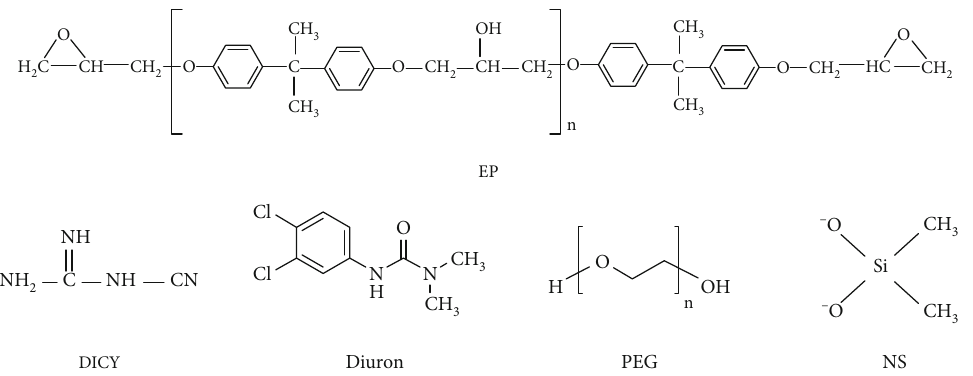
Figure 1: Chemical structures of the EP, DICY, Diuron, PEG, and NS. Table 1: The chemical and physical properties of the EP, DICY, Diuron, PEG, and NS.